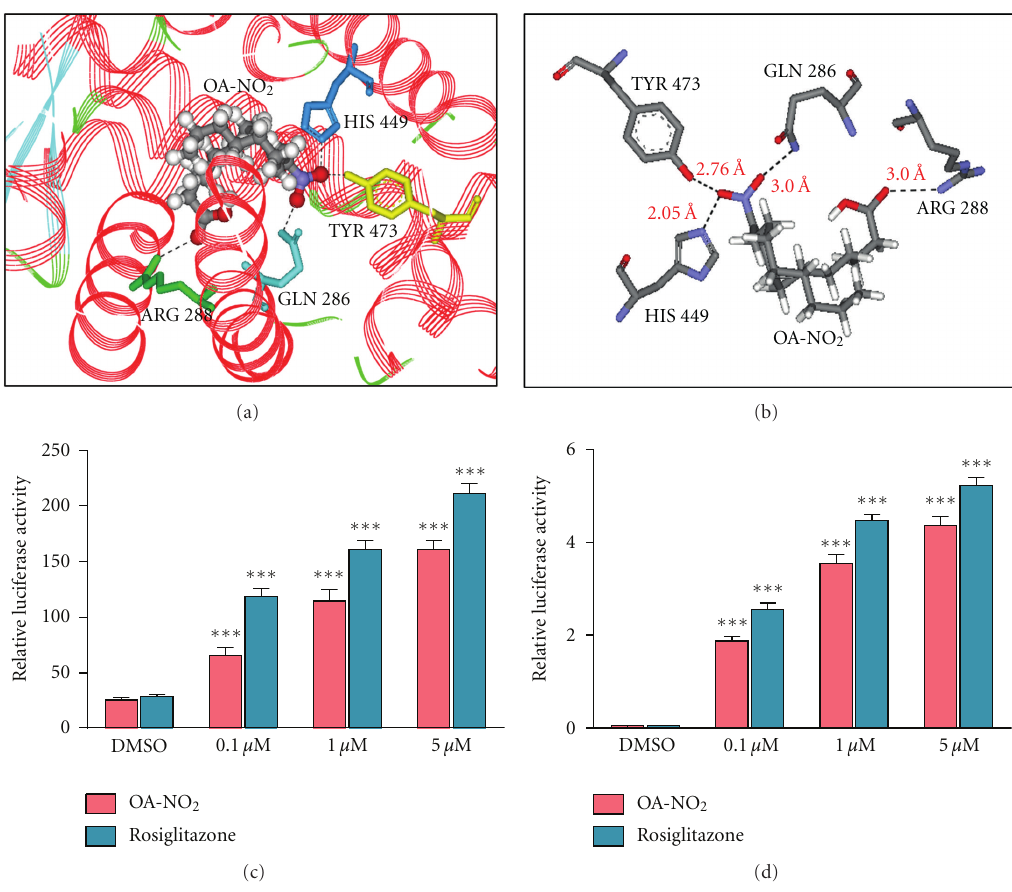
Figure 1: OA-NO 2 activates PPAR- γ in airway epithelial cells. Binding of OA-NO 2 to the PPAR- γ ligand-binding domain was modeled in silico . Results are presented as (a) space-filling representation; (b) schematic representation showing interactions of PPAR - γ residues with specific groups in the OA-NO 2 ligand. Hydrogen bonds are indicated by dotted lines. A549 cells were transiently transfected with pRLSV40 and with one of the following constructs: (c) PPAR-dependent luciferase reporter, pFATPluc; (d) PPAR- γ GAL4 reporter system (UAS G × 4 TK-luciferase + GAL4-PPAR- γ ). Cells were then incubated with vehicle (DMSO), OA-NO 2 (0.1–5 μ M), or rosiglitazone (0.1–5 μ M). After 24h, luciferase activity was measured with a dual luciferase activity kit and normalized to that of Renilla luciferase. Data are representative of one of two independent experiments; n = 6; ∗∗∗ P < 0.001 versus